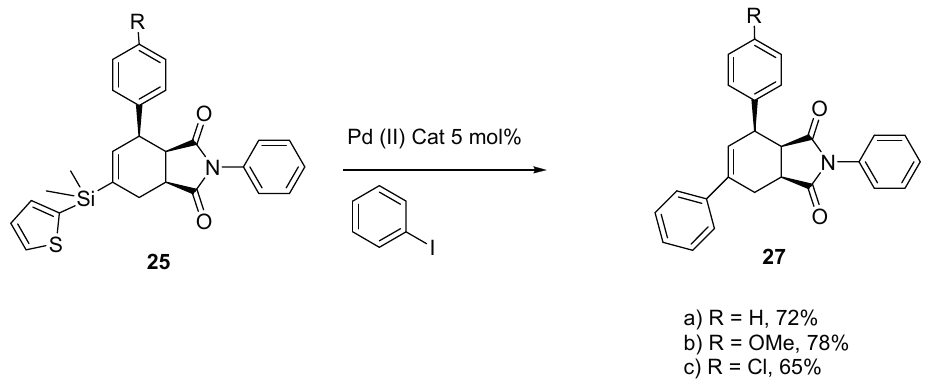
Scheme 9. Cross-coupling of aryl substituted 2-thienyldimethylsilyl-substituted